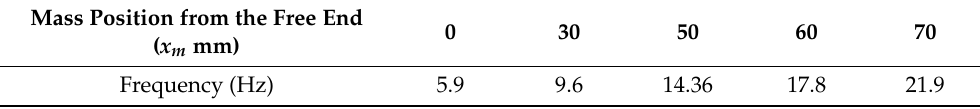
Table 6. The natural frequency of the harvester at different mass positions. Mass Position from the Free